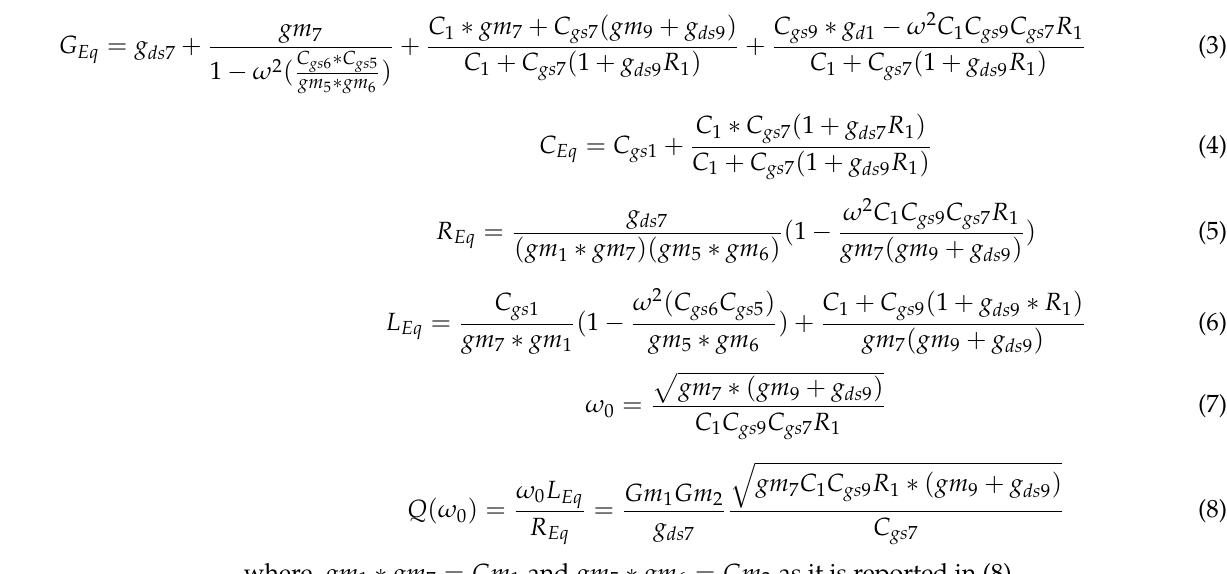
Table 1. Comparison study of the passive and active inductors. Performances Passive Inductor (Spiral)